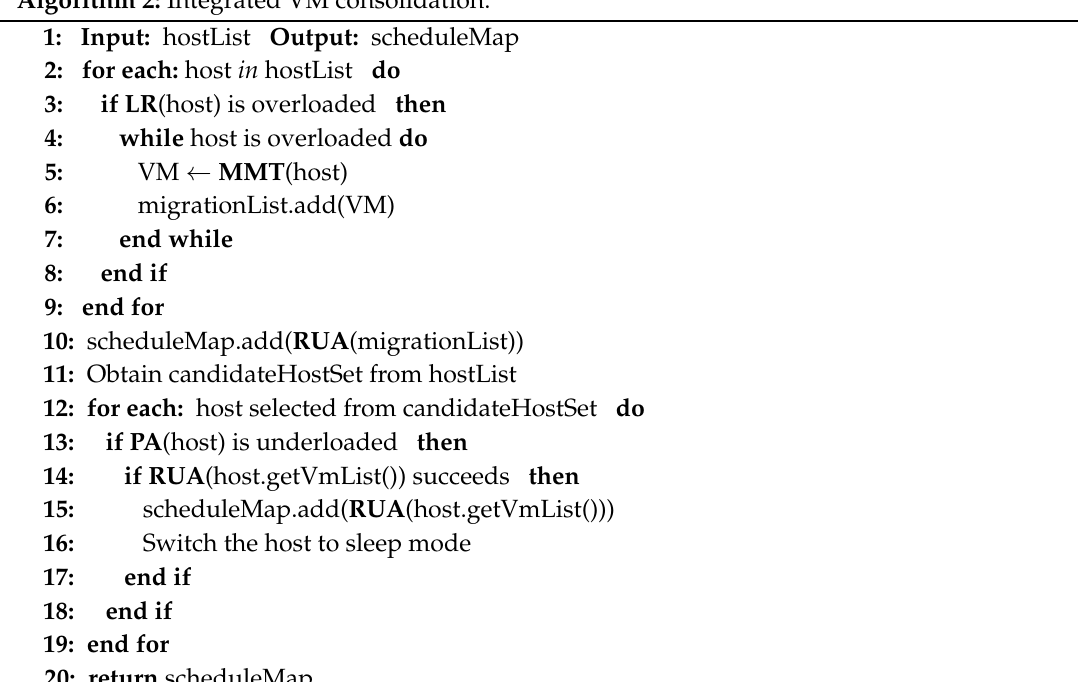
Algorithm 2: Integrated VM